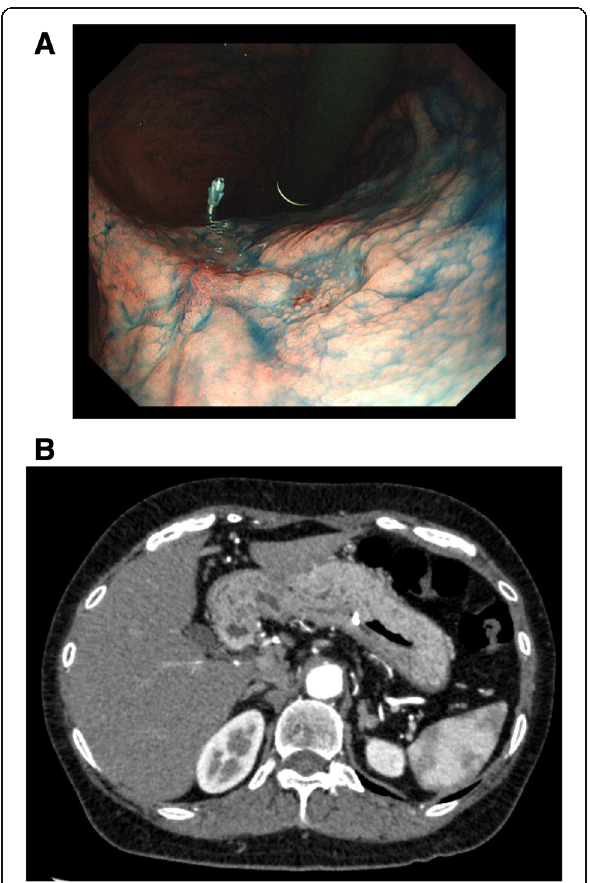
Fig. 1 Gastric endoscopy and CT. a Gastric endoscopy revealed a type 0-IIc tumor, which was located in the posterior wall of the mid- body. Histological findings indicated a poorly differentiated adenocarcinoma. Tumor recession without ulceration indicated tumor invasion deeper into the submucosal layer. b There was no lymph node swelling based on CT. The preoperative clinical stage was cT1b, cN0, cM0, cStage